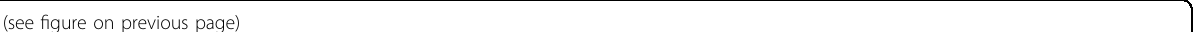
Fig. 1 Immunological memory response of COVID-19 recovered individuals elicited by an inactivated vaccine at 12 months PSO. a Dynamic changes of antibody response in a cohort of COVID-19 recovered individuals from 1 to 12 months. SARS-CoV-2 speci fi c IgG/IgM/IgA and NAb titers were measured with previously described MCLIA kits and pseudovirus-based neutralization assay. Medians (interquartile range, IQR) are shown. The NAb titers were calculated as 50% inhibitory dose (ID 50 ) and the limit of detection (LOD) was 40; the signal to cut-off ratio (S/CO) of IgG/IgM/IgA above 1 was considered as positive. NAb titers ( b ), IgG ( c ), and IgM ( d ) levels of two cohort in which COVID-19 convalescent individuals or healthy participants were injected by two-dose inactivated vaccine CoronaVac; e , f the status of SARS-CoV-2 speci fi c memory B cells in COVID-19 recovered individuals and naive individuals. Enzyme-linked immunosorbent assay (ELISA) ( e ) was performed to detected anti-S, anti-S1 IgG secreted by memory B cells and enzyme-linked immunosorbent spot assay (ELISpot) ( f ) was performed to analyze the number of antibody-secreting cells. OD denotes optical density, S spike protein and S1 fragment of spike glycoprotein. Empty triangles with red and empty circles with blue indicate healthy individuals and SARS-CoV-2 experienced individuals, respectively; the horizontal dashed lines denote the lower LOD. In a – d , boxes denote the median, fi rst and third quartiles, while the whiskers show ×1·5 interquartile range (IQR) of antibody levels. In e , f , boxes and error bars denote mean ± standard deviation. Statistical analysis was performed with the use of the two-tailed, nonparametric Mann – Whitney U